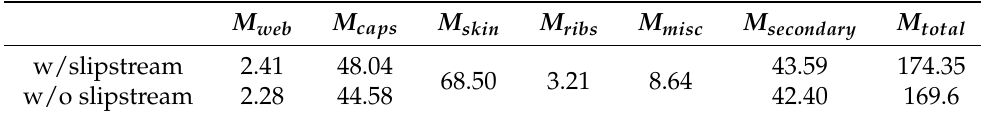
Table 5. Mass breakdown (kg) of the X-57 Maxwell wing with and without slipstream effects